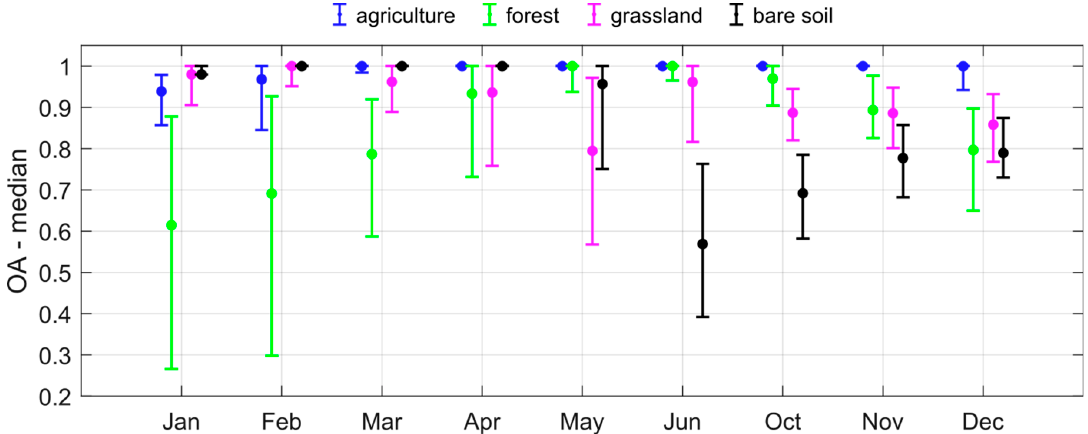
Figure 6: Monthly median and interquartile range of Overall Accuracy averaged over the period 01 January 2011 to 30 September 2016, depending on the land cover classes defined in Figure 1c.